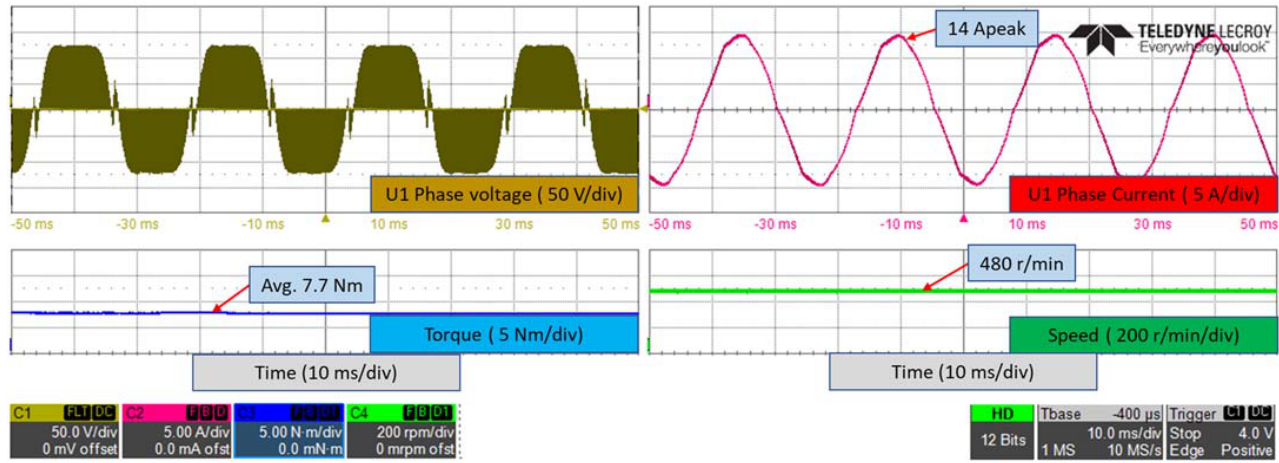
Figure 14. Torque curves at 480 r/min and 10 A for three-phase operation.